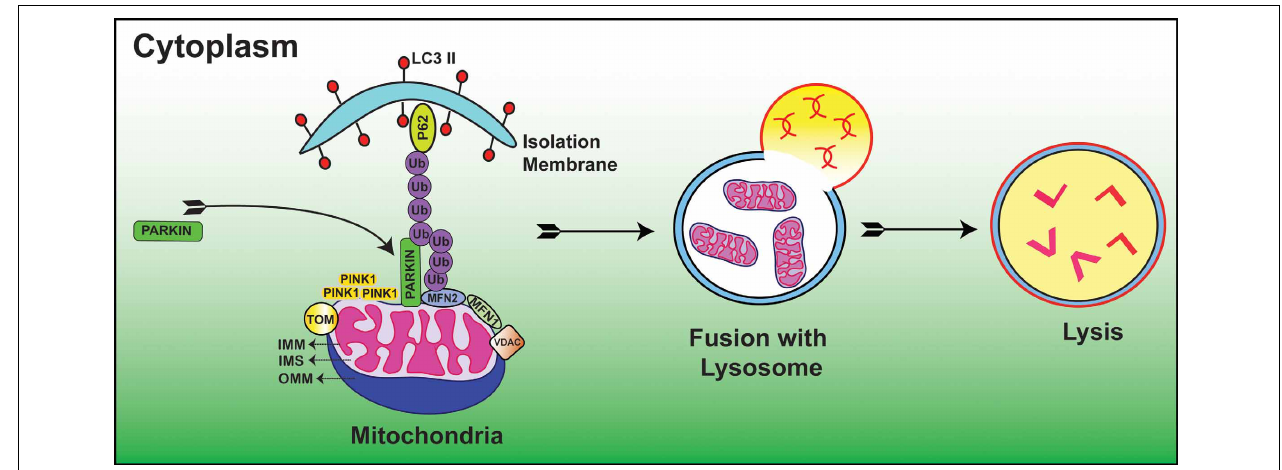
FIGURE 1 | Diagrammatic representation showing the molecular events of Parkin/PINK1 mediated mitophagy process. Low (cid:2) ψ m suppresses the activityofTOMcomplexandleadstotheaccumulationofPINK1.Thisisfollowed by translocation of Parkin from cytoplasm to mitochondria where it is activated by PINK1. Subsequently, Parkin ubiquinates OMM proteins including but not